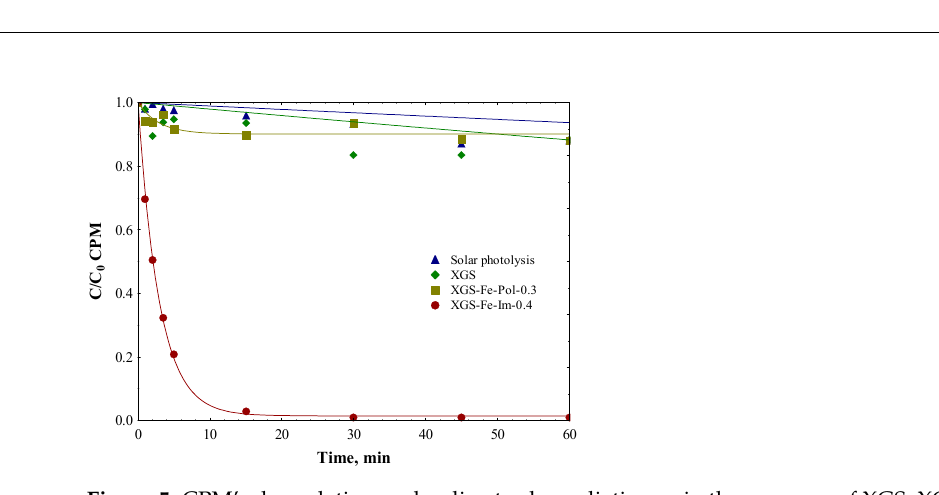
Figure 5. CPM’s degradation under direct solar radiation or in the presence of XGS, XGS-Fe-Pol-0.3, or XGS-Fe-Im-0.4. Load of 1 g/L, C 0 = 15 ppm. Table 4 enlists the experiments performed, as well as the kinetic constants obtained for the first-order model and the two-parameter first-order model, this model has been reported for the fitting of experimental data in heterogeneous photocatalytic processes [31]. It can be observed that, for the materials obtained through impregnation, the two- parameter first-order model fitted the experimental data better, achieving lower deviation percentages than those obtained by the first-order model. Therefore the 2-parameter model’s representation is the one used in the graphs presented in this study. Table 4. List of experiments and kinetic constants obtained along with the deviation percentage.